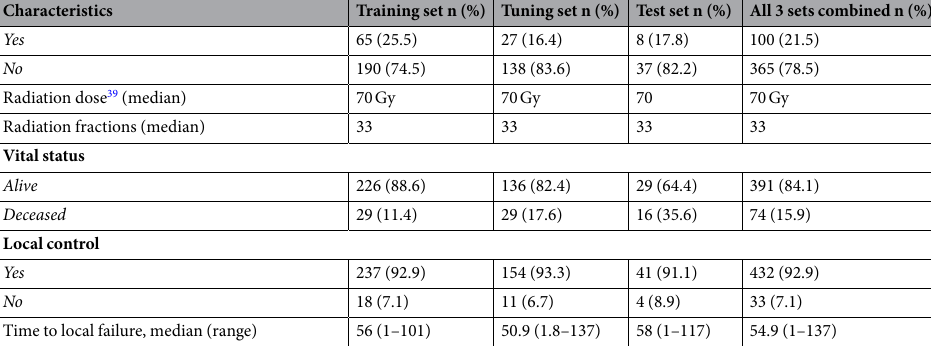
Table 1. Demographics, disease and treatment characteristics for the three